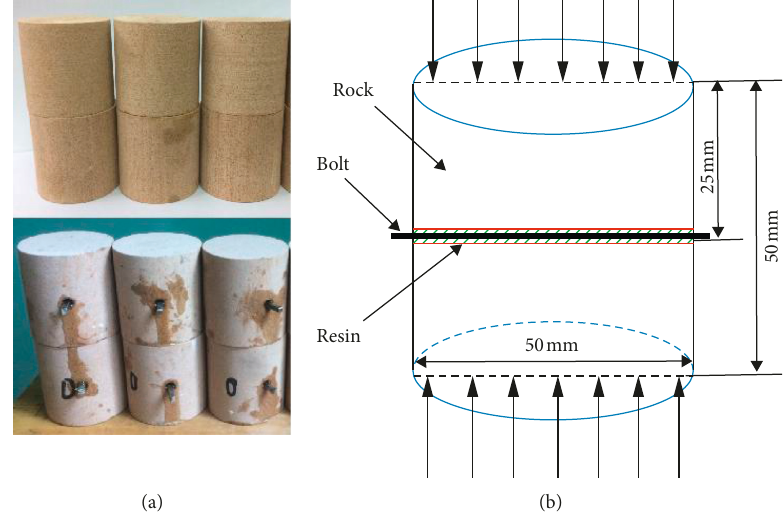
Figure 3: Specimen preparation. (a) The unreinforced and reinforced samples. (b) The bolt arrangement.